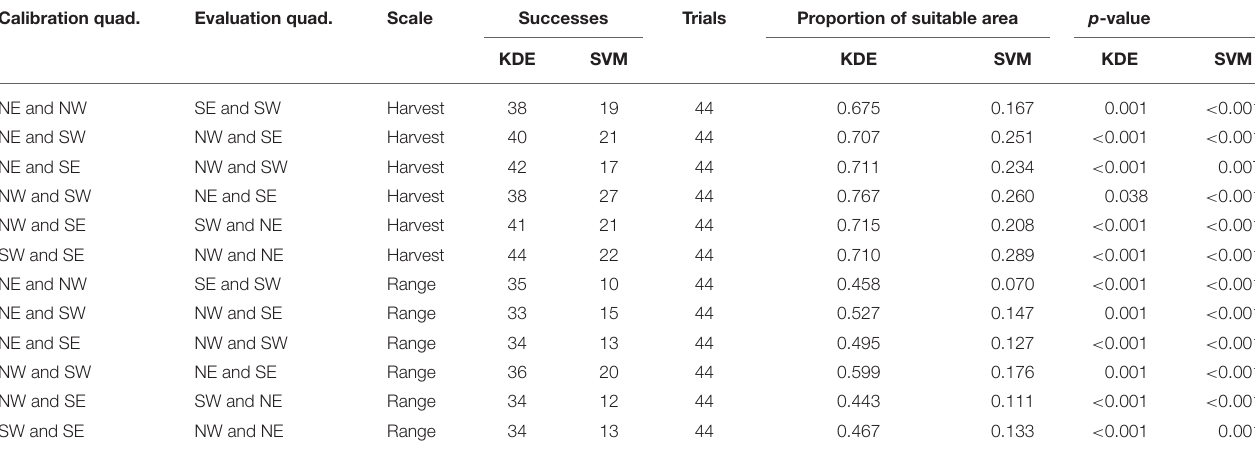
TABLE 1 | Evaluation of binary suitability maps generated from both algorithms under all quadrant and scale combinations. Calibration